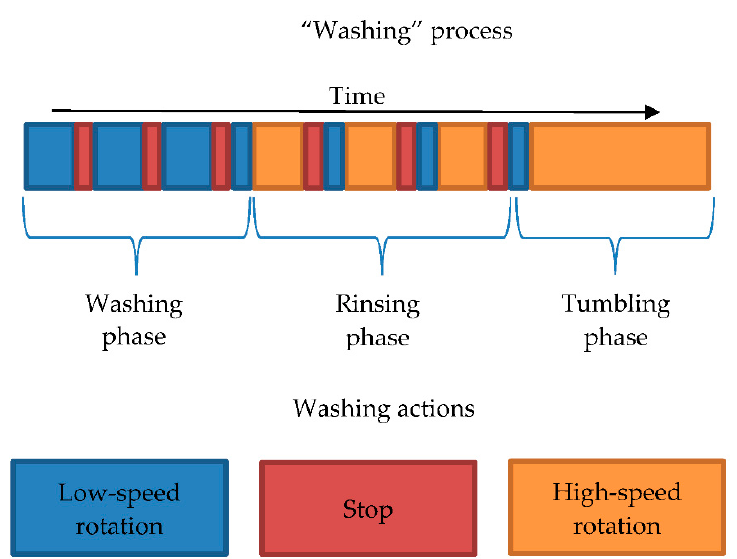
Figure 3. Configuration of washing phases and actions.